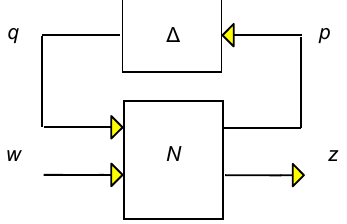
Figure 5. Uncertainty modeling N- Δ structure.